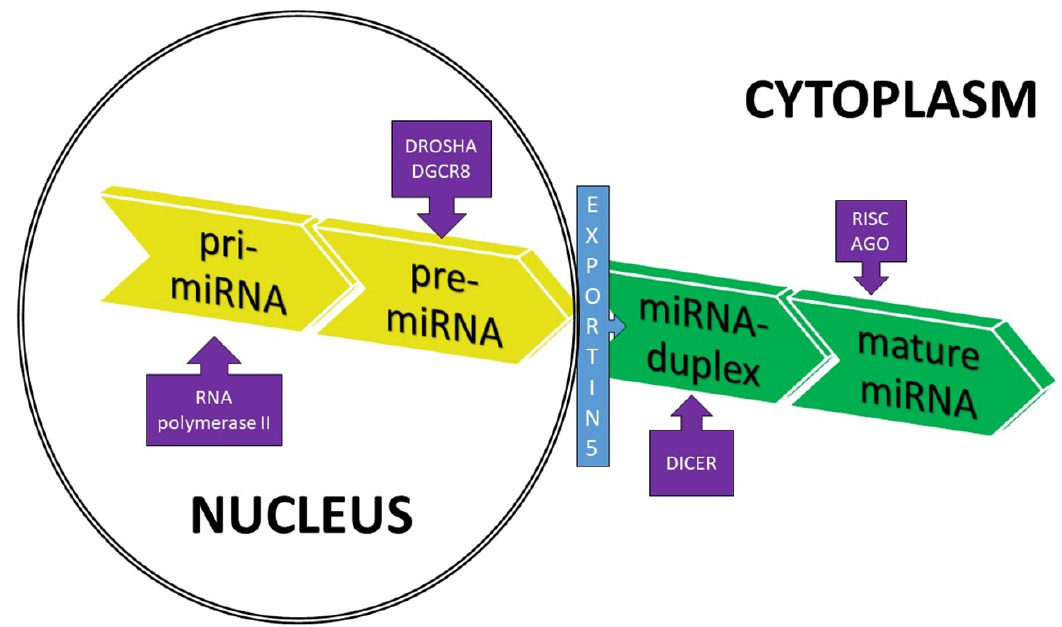
Figure 1. Schematic overview of microRNA (miRNA) biogenesis. DROSHA—RNase III enzyme; DGCR8—DiGeorge syndrome critical region 8; DICER—RNase III enzyme; RISC—RNA-induced silencing complex; and AGO—Argonaute protein.